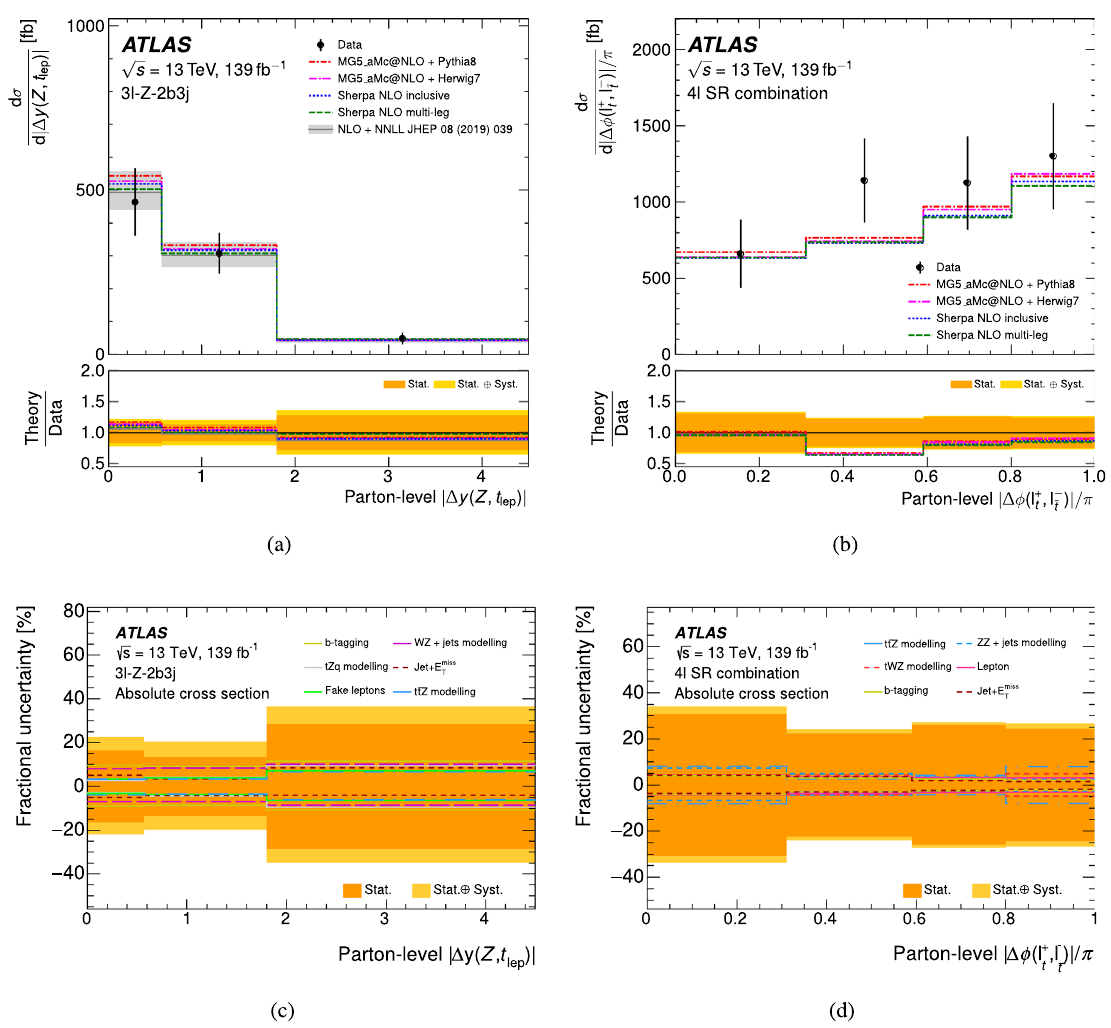
Fig. 14 Absolute differential t ¯ tZ cross sections measured at parton level as a function of a the rapidity difference ( | (cid:8) y | ) between the Z boson and the reconstructed top quark and b the azimuthal separa-